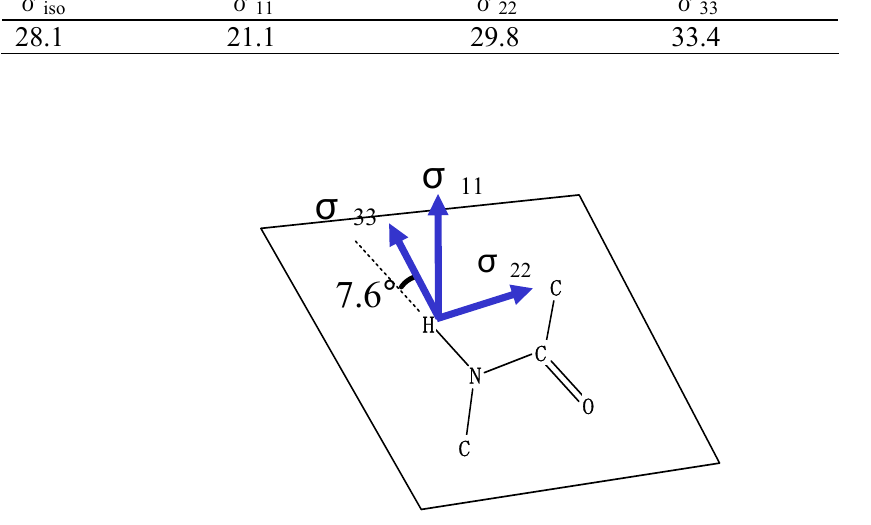
, σ and σ of the hydrogen- 11 22 33